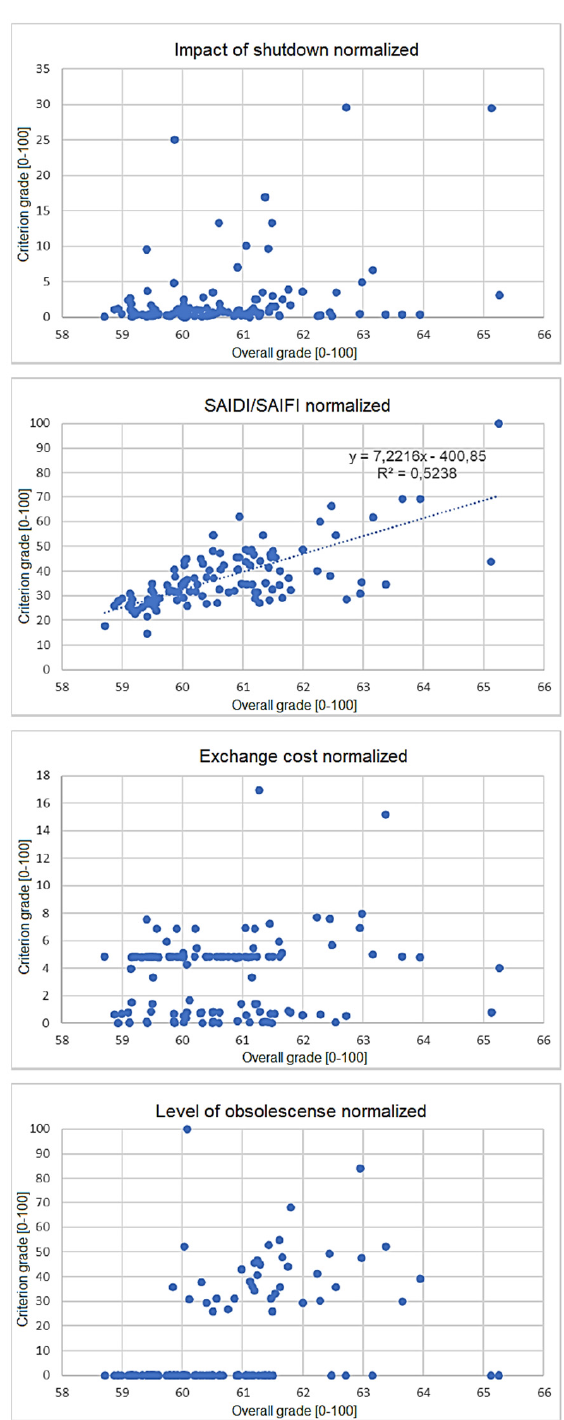
Figure 11. Dispersion of assets when individualized criteria were evaluated [authors].